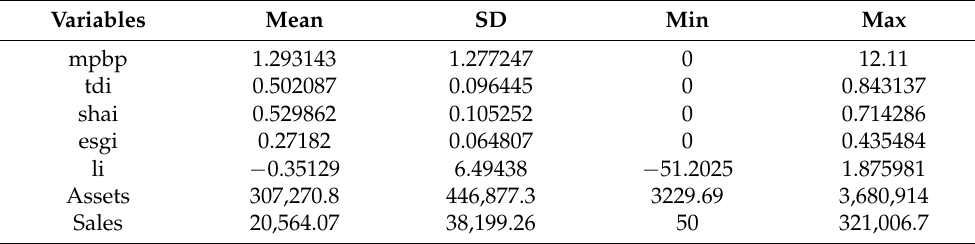
Table 2. Descriptive